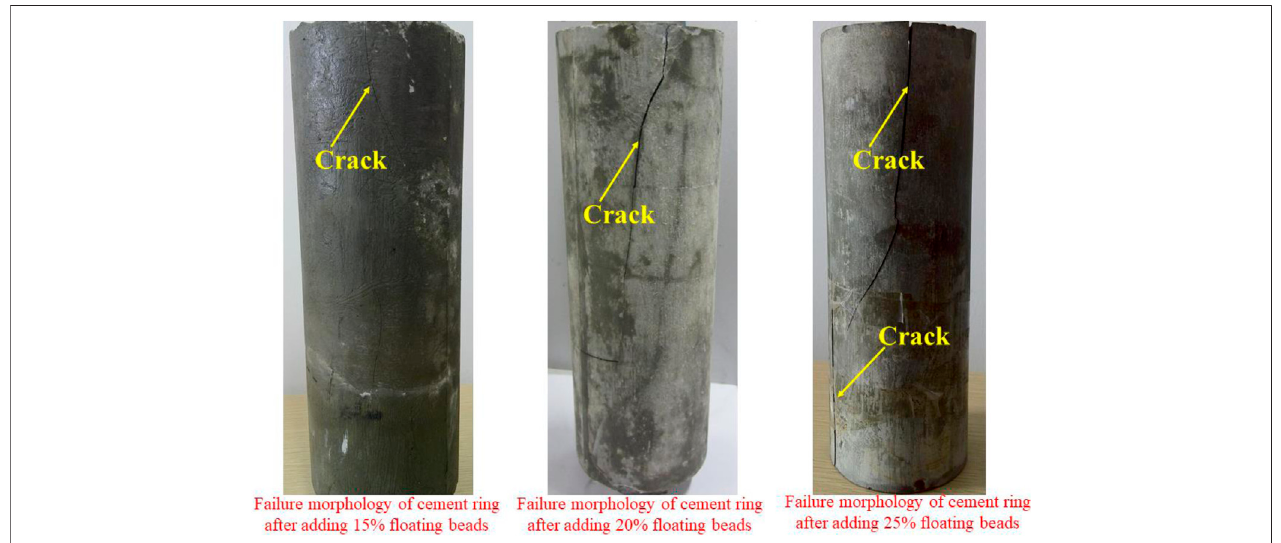
FIGURE 7 | Macro-morphology of cement rings with different amounts of fl oating beads after failure.